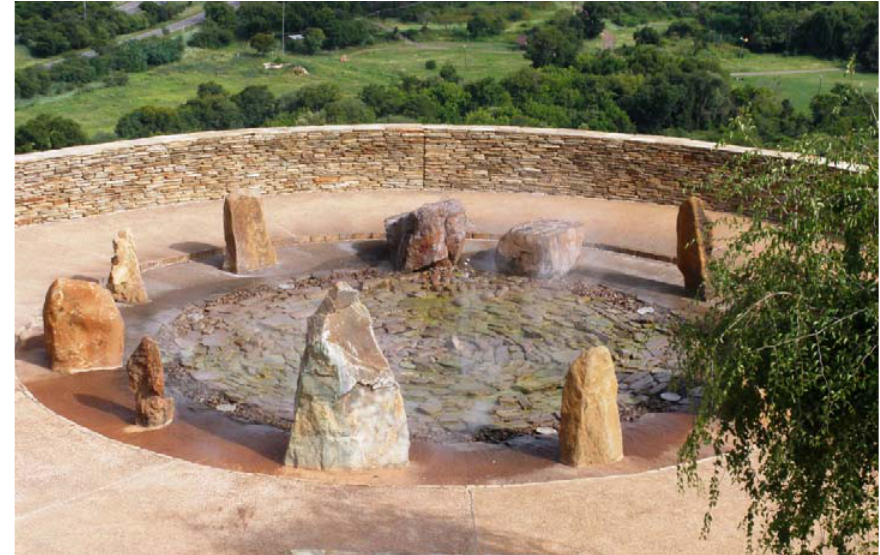
Figure 19. Isivivane pool with stones from the nine provinces, Freedom Park, Pretoria (author’s